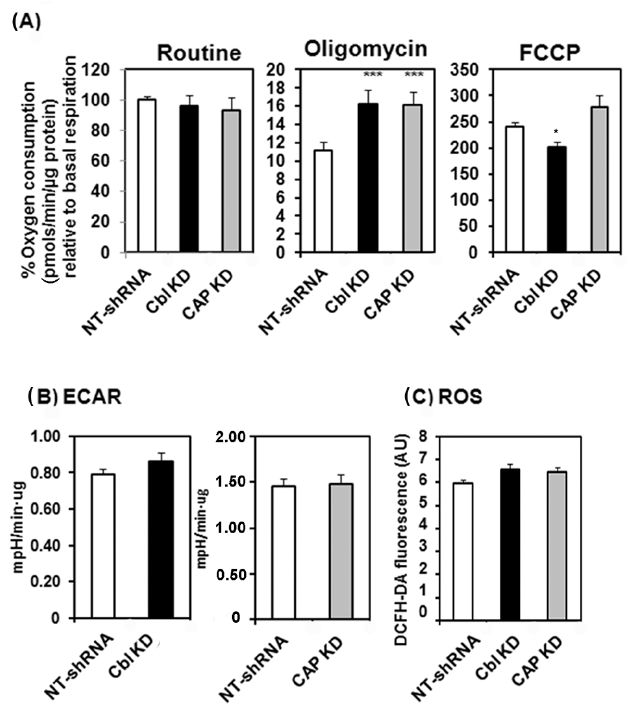
Figure 3. CBL- and CAP-depleted myocytes show alterations in mitochondrial respiration. ( A ) Oxygen consumption in CBL and CAP knockdown cells compared to control cells expressing NT-shRNA. The data show the mean ± SEM of a representative experiment. Routine: basal respiration, FCCP 0.5 µ M, oligomycin 2.5 µ M concentrations. Statistical analysis: one-way ANOVA to NTshRNA-expressing cells. * indicates p < 0.05, *** indicates p < 0.001. ( B ) Extracellular acidification rates (ECAR) values, data show mean ± SEM of a representative experiment. Not statistically significant. ( C ) Reactive oxygen species. Cell mitochondria were stained with DCFH-DA as specified in Materials and Methods and emission fluorescence quantified at 560 nm. Graphs show mean ± SEM values of fluorescence intensity (arbitrary units) of n = 163 control, n = 126 CBL KD, and n = 192 CAP KD cells. Statistics: one-way ANOVA, not statistically significant.